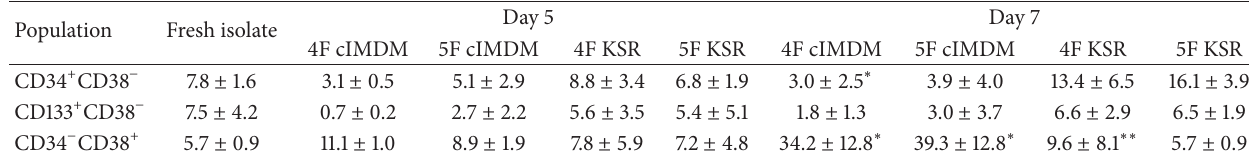
Table 3: Immunophenotype of subpopulation of expanded cells analyzed by flow cytometry at days 5 and 7.